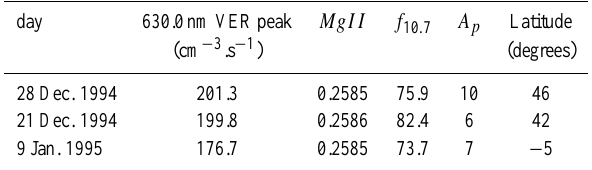
Table 2. Geophysical parameters for the three selected days repre- sented in the frame in Fig. 12. The first date corresponds to the point at the top of the frame and the last date to the point at the